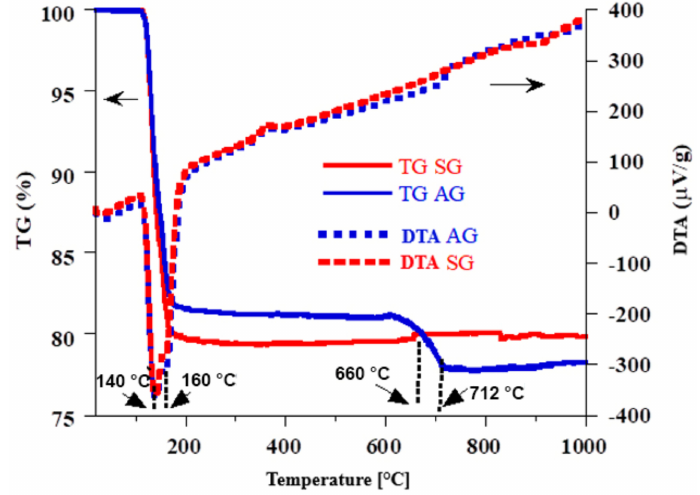
Figure 5. Thermal Gravimetric TG and Di ff erential Thermal Analysis DTA curves for gypsum